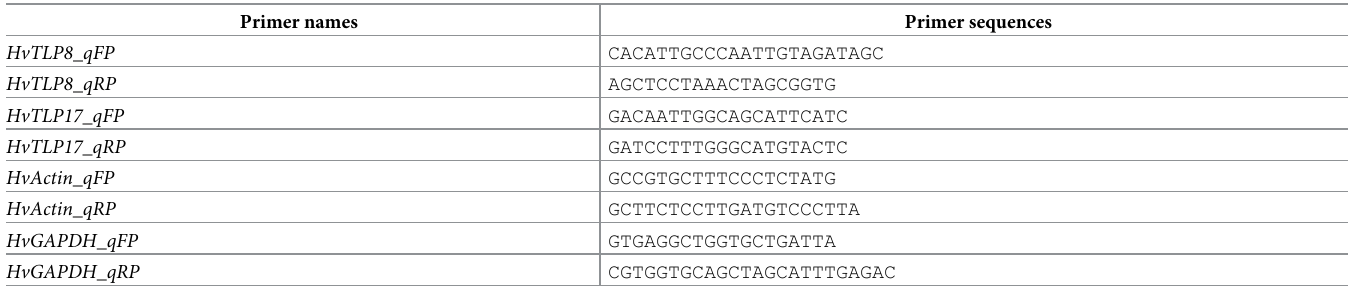
Table 2. Primers used for qRT-PCR expression